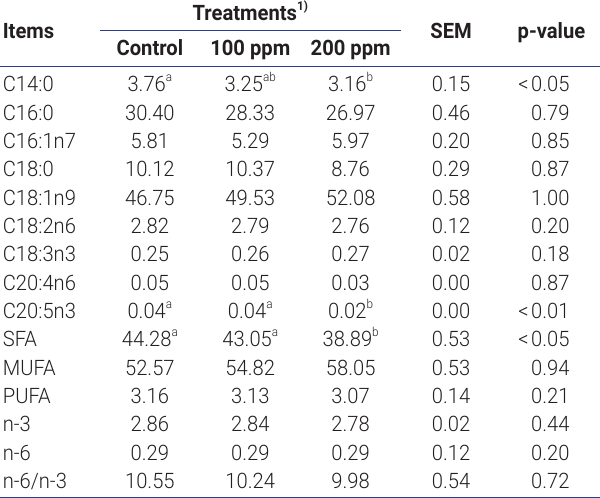
Table 7. Effect of rumen protected γ-aminobutyric acid supplemen - tation on total fatty acid concentration (%) of Hanwoo steers Treatments Items